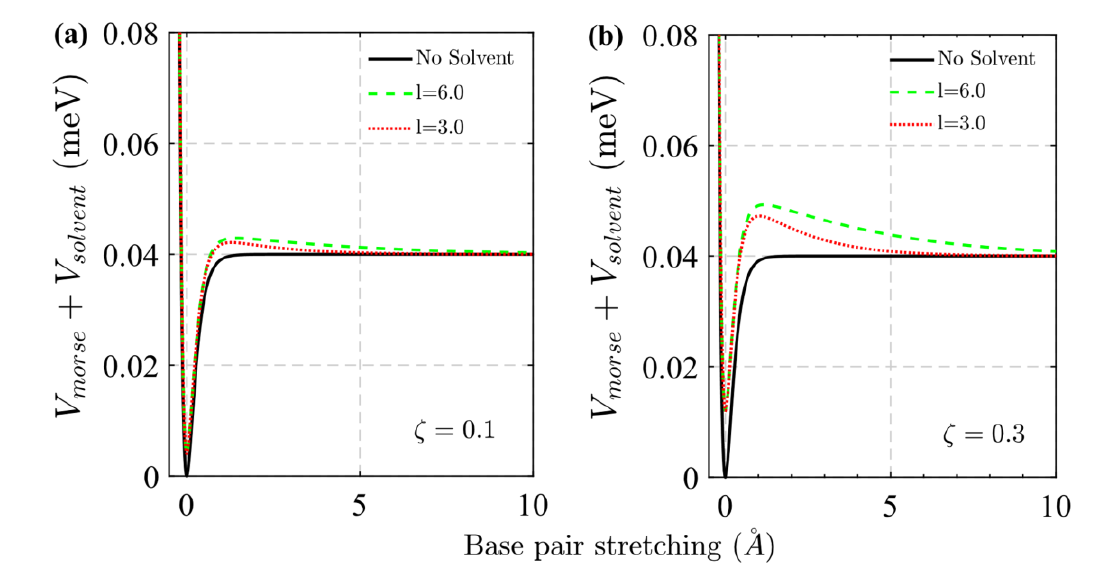
Figure 2. Potential term in DNA system by including the solvent potential with (a) viscosity ζ=0.1 (b)